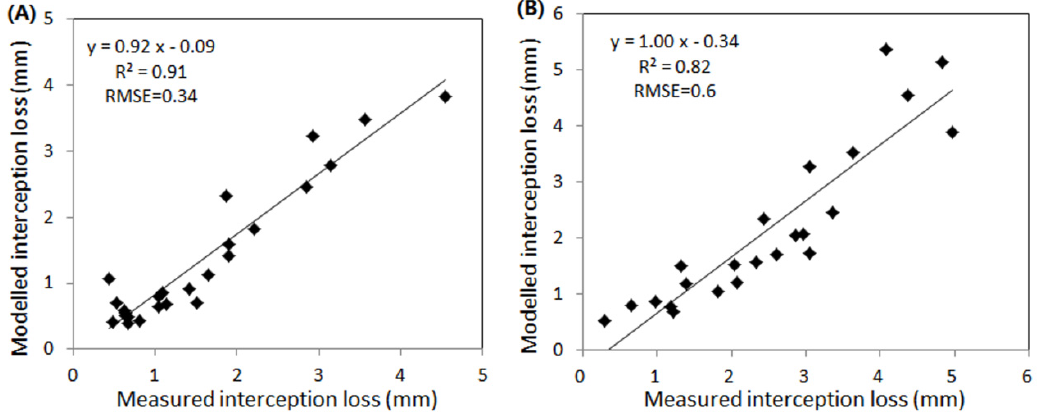
Figure 3. Validation of the modelled interception loss of a single rainfall using the RS-Gash model against field measurements for the period from 13 June to 7 October 2008.